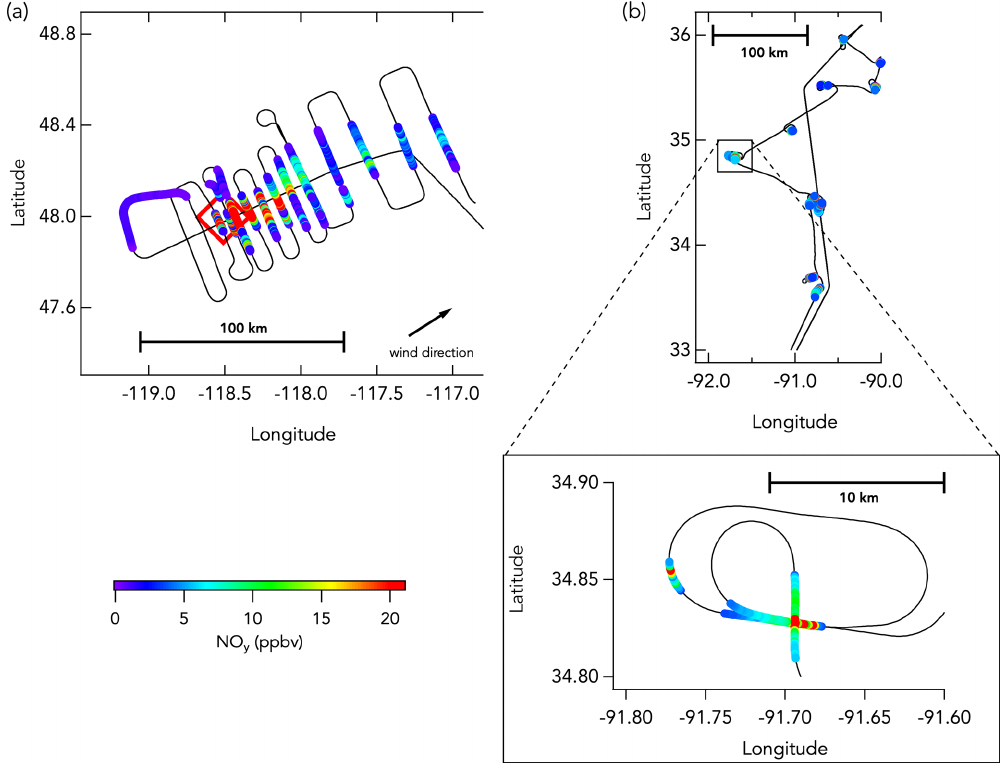
Figure 1. Example DC-8 flight tracks from western wildfires and eastern agricultural fires. Panel (a) shows the DC-8 flight track (black line) during the sampling of the Williams Flat fire (3 August 2019; fire location indicated by the red box) smoke plume, colored by NO y mixing ratios (only data in smoke are colored here). Panel (b) shows the DC-8 flight track during the sampling of multiple agricultural burns (21 August 2019) that has also been colored by NO y mixing ratios (only data in smoke are colored